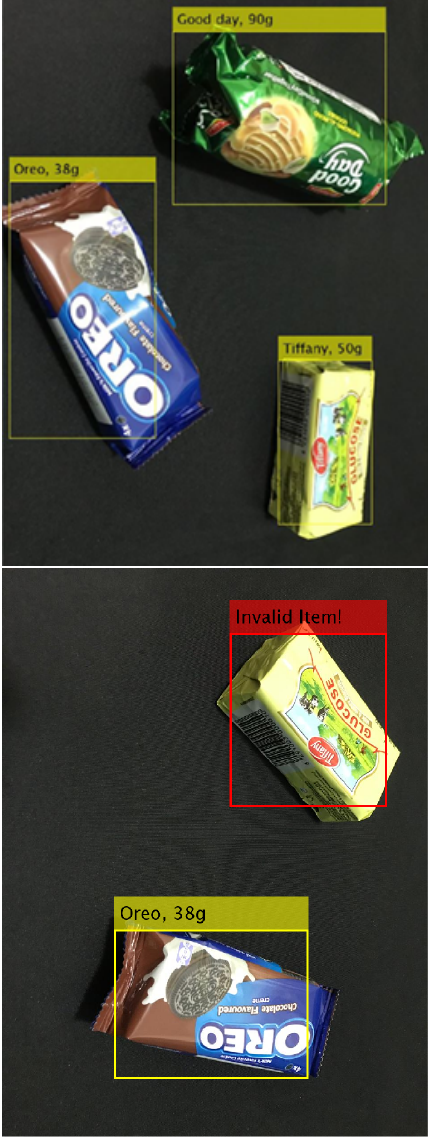
Figure 29. Results of the validation